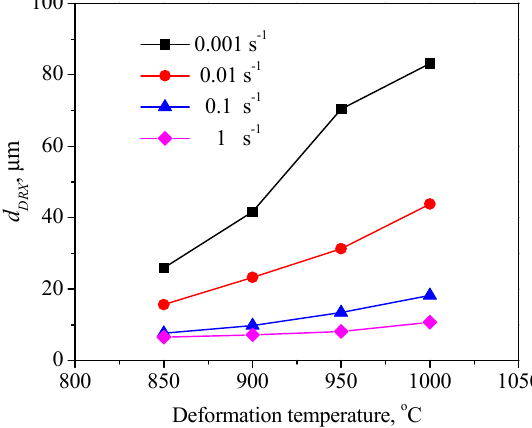
X ) with deformation DRX